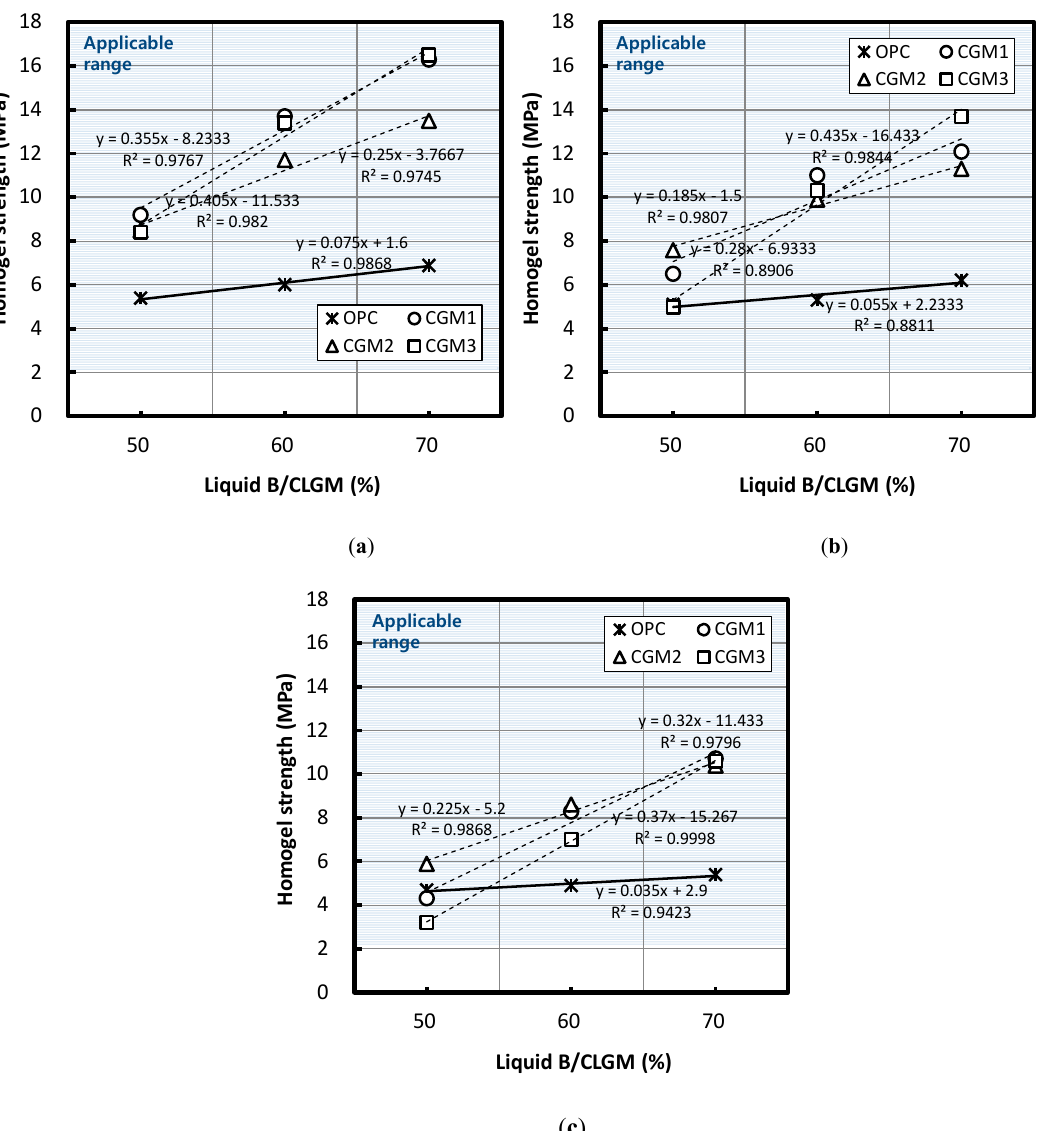
Figure 7. Homogel strength based on volume replacement ratio of Liquid B for a W/B ratio equal to ( a ) 100%, ( b ) 120%, and ( c ) 140%. Table 9. Estimated values of homogel strength according to volume replacement ratio of Liquid B (7 days).